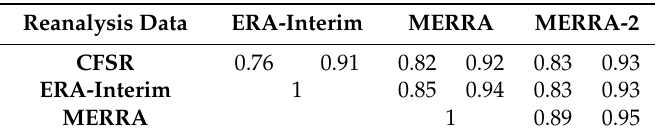
Table 4. Coefficient of determination ( R 2 ) among hourly reanalysis data at HeMOSU-1 location (left: wind speed, right: wind